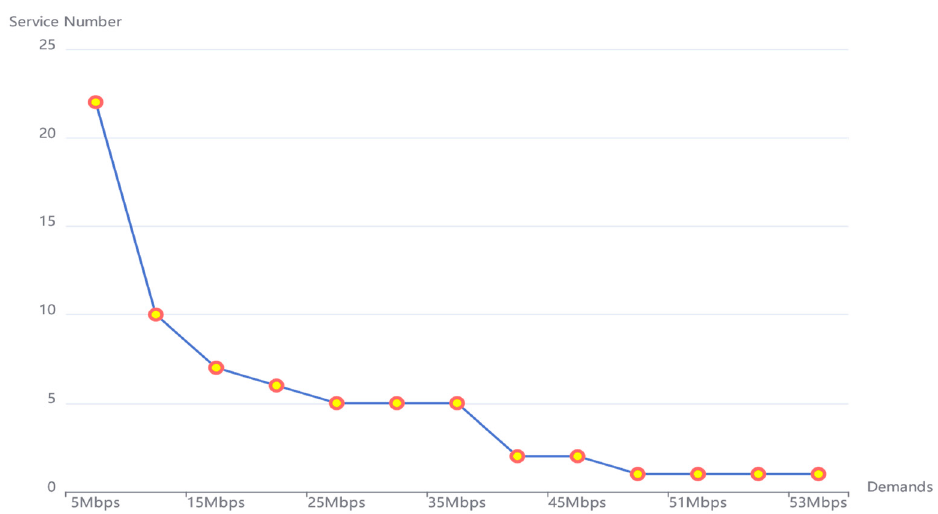
Figure 4. Max service number under various communication demands.